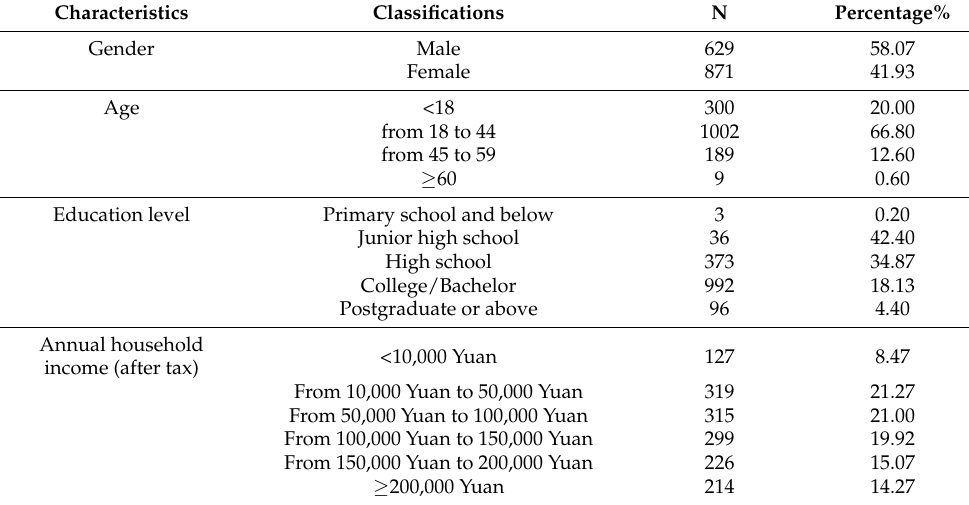
Table 3. Demographic characteristics of the